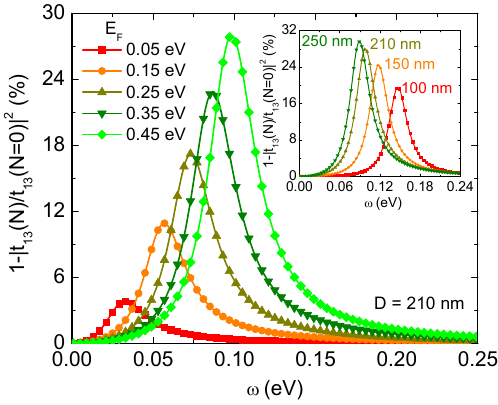
Figure 3. (Color online) Theoretical extinction spectra for systems having a graphene-disk array with D = 210 nm and the width of 60 nm at different values of the chemical potential E F . The inset shows theoretical extinction spectra with E F = 0.45 eV and at several diameters of graphene nanodisks separated with their nearest neighbors by 60